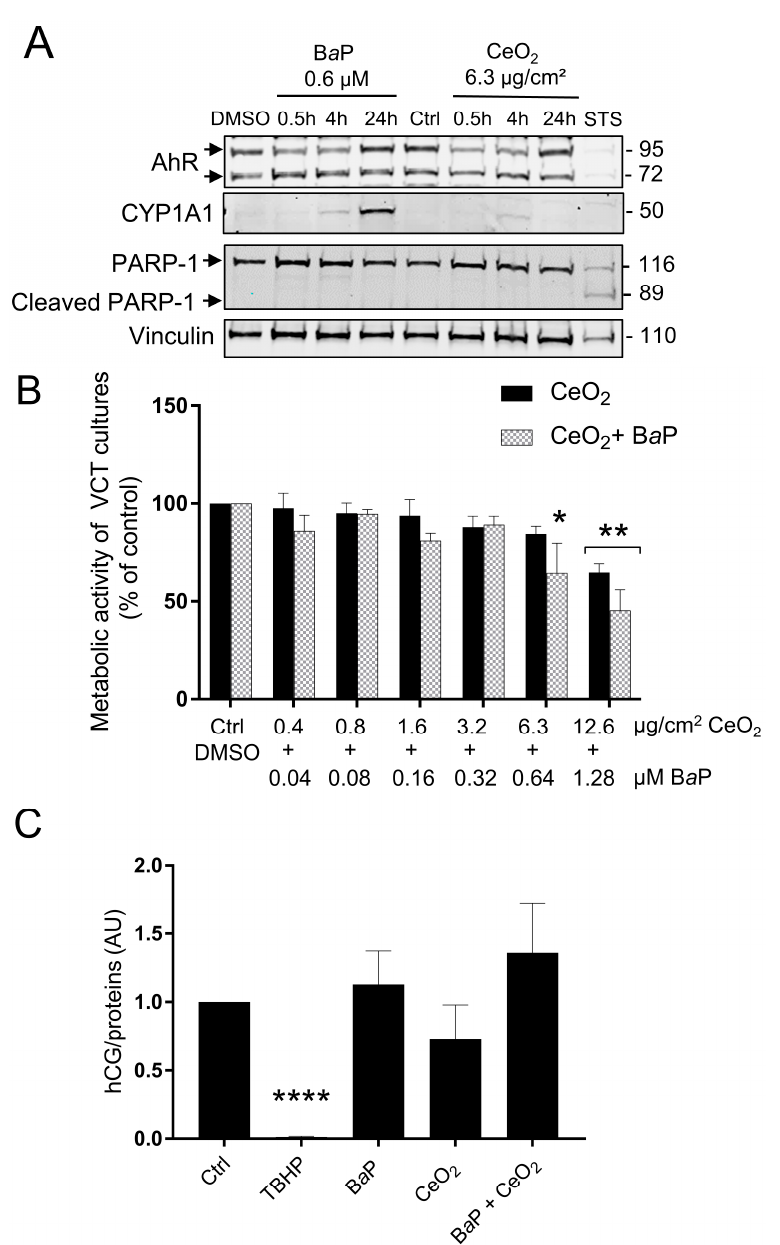
Figure 2. Effect of benzo(a)pyrene and cerium dioxide nanoparticles on the AhR pathway and metabolic activity of human primary trophoblasts. VCT purified from term placentas were plated overnight. They were then incubated either with DMSO or with B a P and/or CeO 2 NP at the indicated concentrations for 30 min, 4 h, 24 h, or 72 h, or with 0.5 µ M of STS for 4 h. ( A ) Total protein extracts were subjected to SDS-PAGE under reducing conditions and membranes were immunoblotted with anti-AhR, anti-CYP1A1, anti-PARP-1, and anti-vinculin antibodies (the latter was used as loading control). ( B ) WST-1 assay showing metabolic activity of VCT as mean +/ − SEM ( n = 3) relative to DMSO after 72 h of treatment. * p < 0.05, ** p < 0.01 vs. DMSO. ( C ) The human chorionic gonadotropin (hCG) assay was performed by enzyme-linked immunosorbent assay in VCT supernatants. VCT were incubated for 48 h with 1 µM of B a P and/or 10 µg/cm 2 of CeO 2 NP, or 500 µM of TBHP. The hCG assays were normalized to µg of protein per condition. Results represent the mean +/ − SEM ( n = 3) relative to control (Ctrl). **** p < 0.0001 vs. Ctrl.